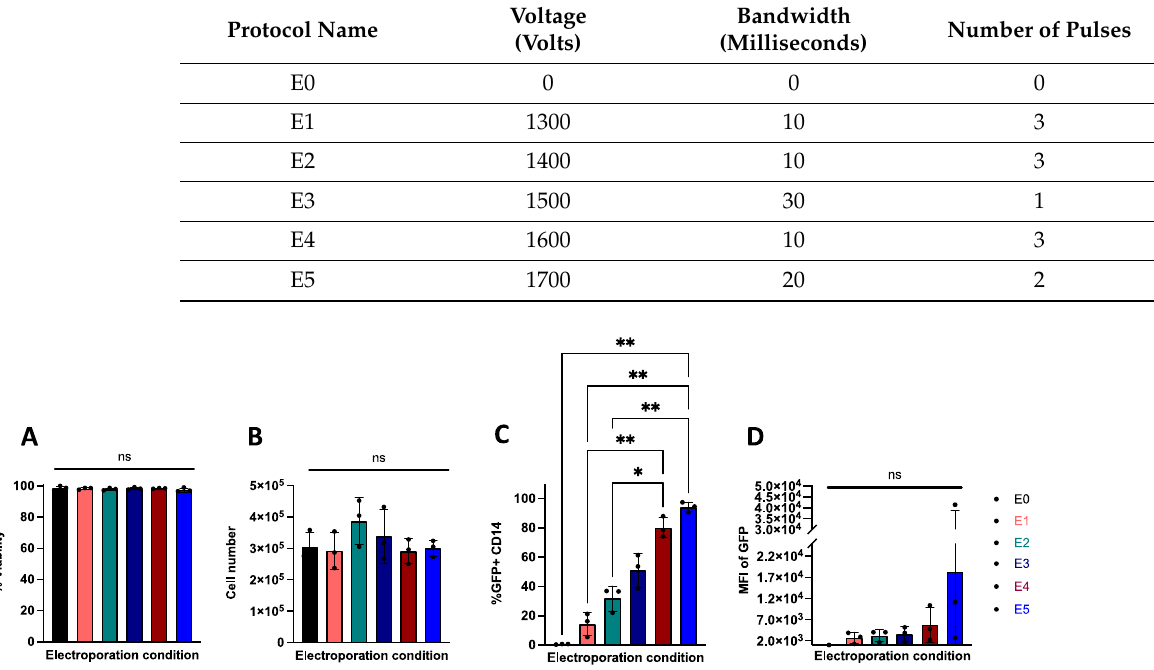
Table 1. Electroporation conditions. Voltage, bandwidth, and pulse settings tested for electroporation of primary human monocytes.